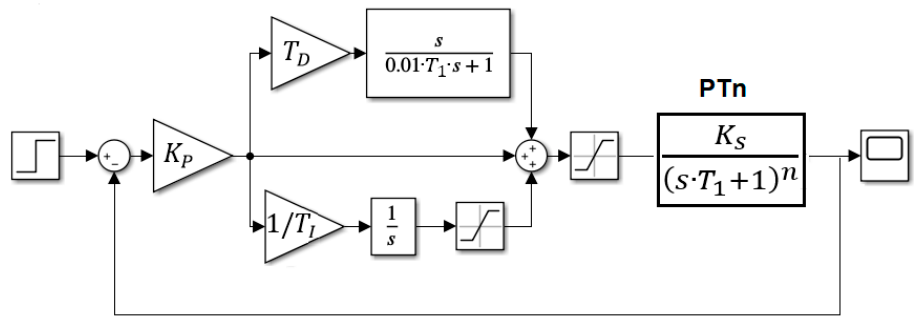
Figure 1. Block diagram with a PID-controlled PTn system.